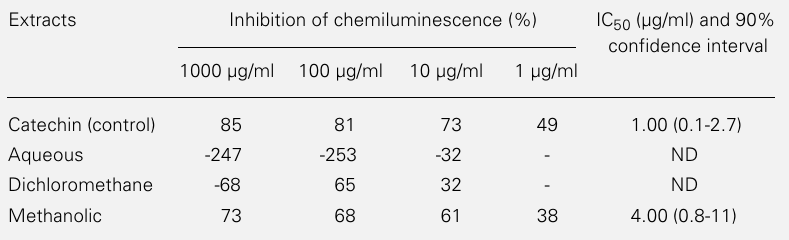
Table 1 - Antioxidant activity in extracts of P. peltata using the hydroperoxide-initiated chemiluminescence assay. Inhibition of chemiluminescence was calculated by [1 - (Esm/Ecm)] x 100. Esm: emission intensity of test samples at maximum emission; Ecm: emission intensity of the control at maximum emission. Catechin was used as a standard. A negative value for inhibition indicates an increase in light emission compared with controls. ND, Not deter-